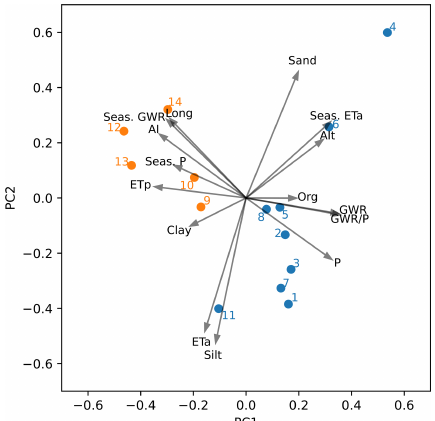
Figure 8. A principle component analysis biplot for which the included variables at the 14 sites are as follows: potential an- nual groundwater recharge (GWR); annual precipitation ( P ); an- nual potential evapotranspiration (ET p ); annual actual evapo- transpiration (ET a ); the fraction of groundwater from precipita- tion (GWR /P ); seasonalities (Seas.) in GWR, P , and ET a ; lon- gitude (Long); altitude (Alt); and sand, silt, clay, and organic mat- ter (Org) percentages. Clusters of monitoring sites with similar char- acteristics are shown in orange and blue. The clustering with Eu- clidean affinity and ward linkage as well as the biplot were produced using the Scikit-learn module of Pedregosa et al. (2011) in Python.